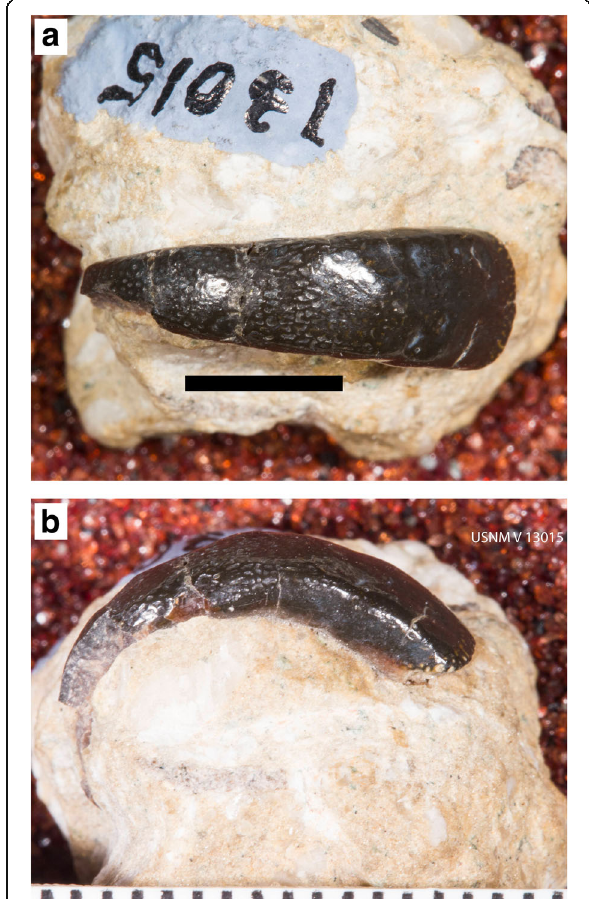
Fig. 10 Syntype of Deltodopsis ? convexus, USNM V13015. Here designated as Arcuodus bialveatus , comb. nov. a Occlusal view. Lingual end to right. Scale bar = 5 mm. b Lateral view. Lingual end to right. Millimeters scale divisions. Drawings of this specimen